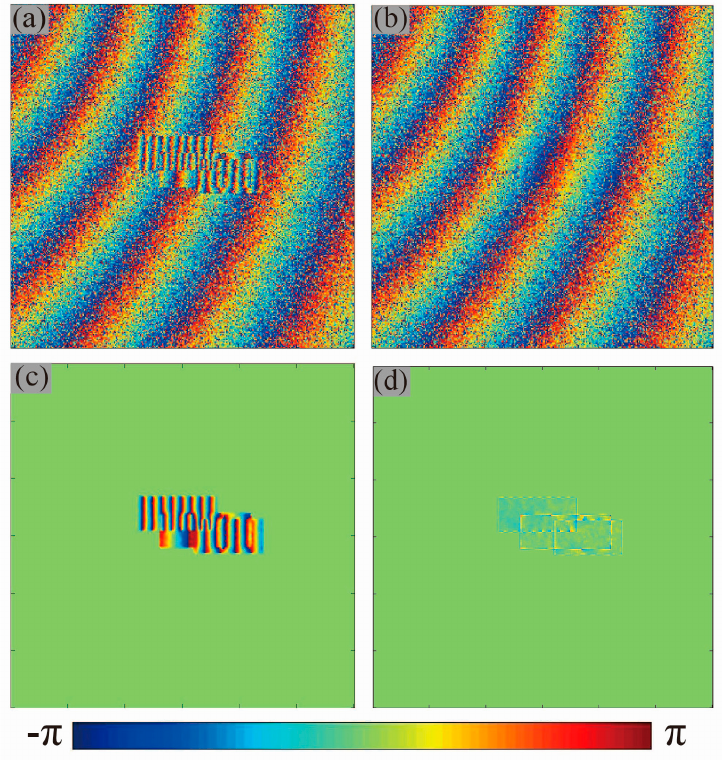
Table 3. Parameters for TerraSAR-X data simulation.